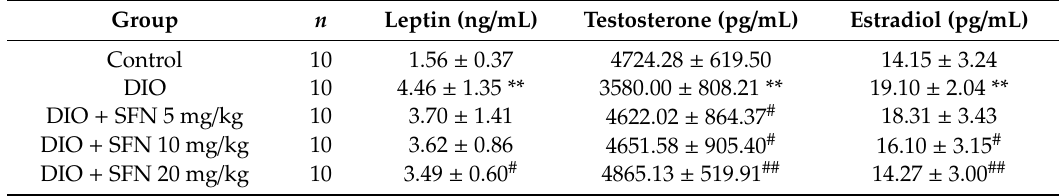
Table 2. E ff ects of SFN on serum hormone levels in obese mice (X ± SD). Table 2. Effects of SFN on serum hormone levels in obese mice (X ± SD). Group n Leptin (ng / mL) Testosterone (pg / Group n Leptin (ng/mL) Testosterone (pg/mL) Estradiol (pg/mL)